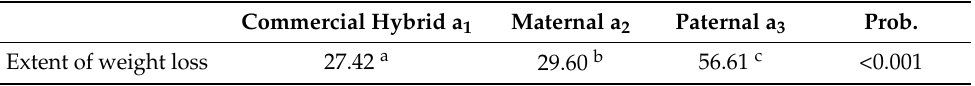
Table 1. Extent of weight loss of beak-abrasive materials in the case of different genotypes over a 13-week study period